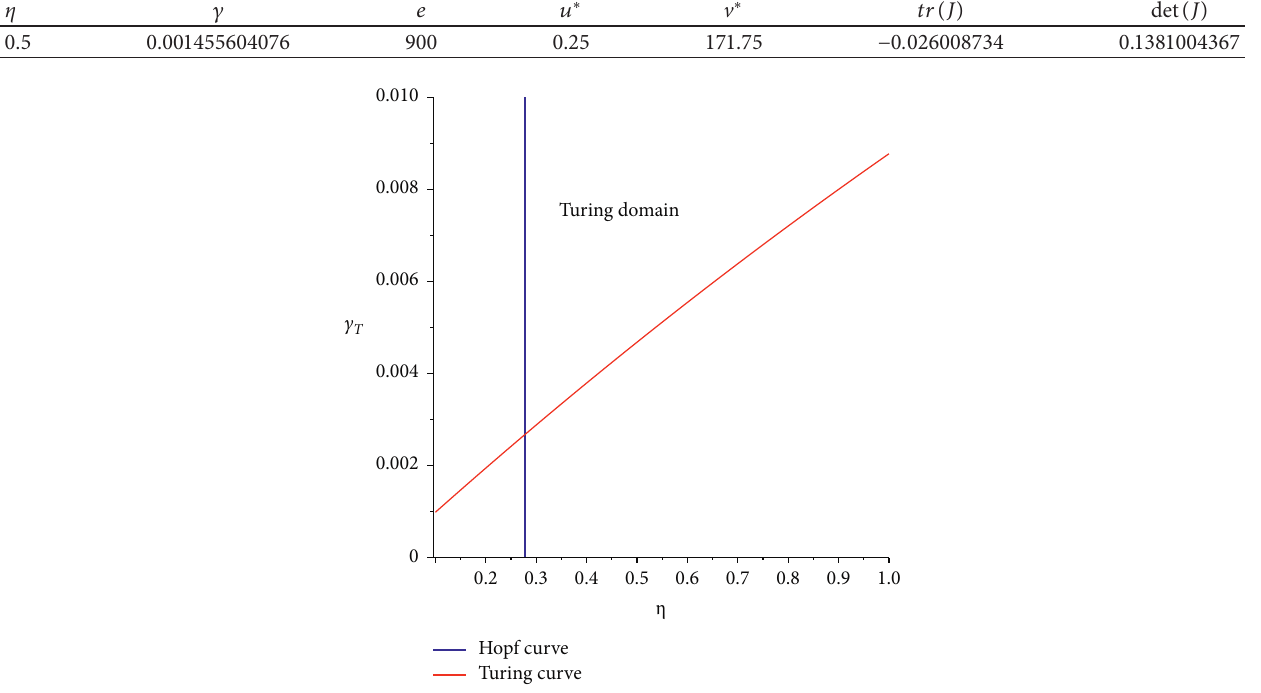
Table 2: A concrete example to illustrate the existence and stability of the equilibrium E ∗ ( u ∗ , v ∗ ) . η c e